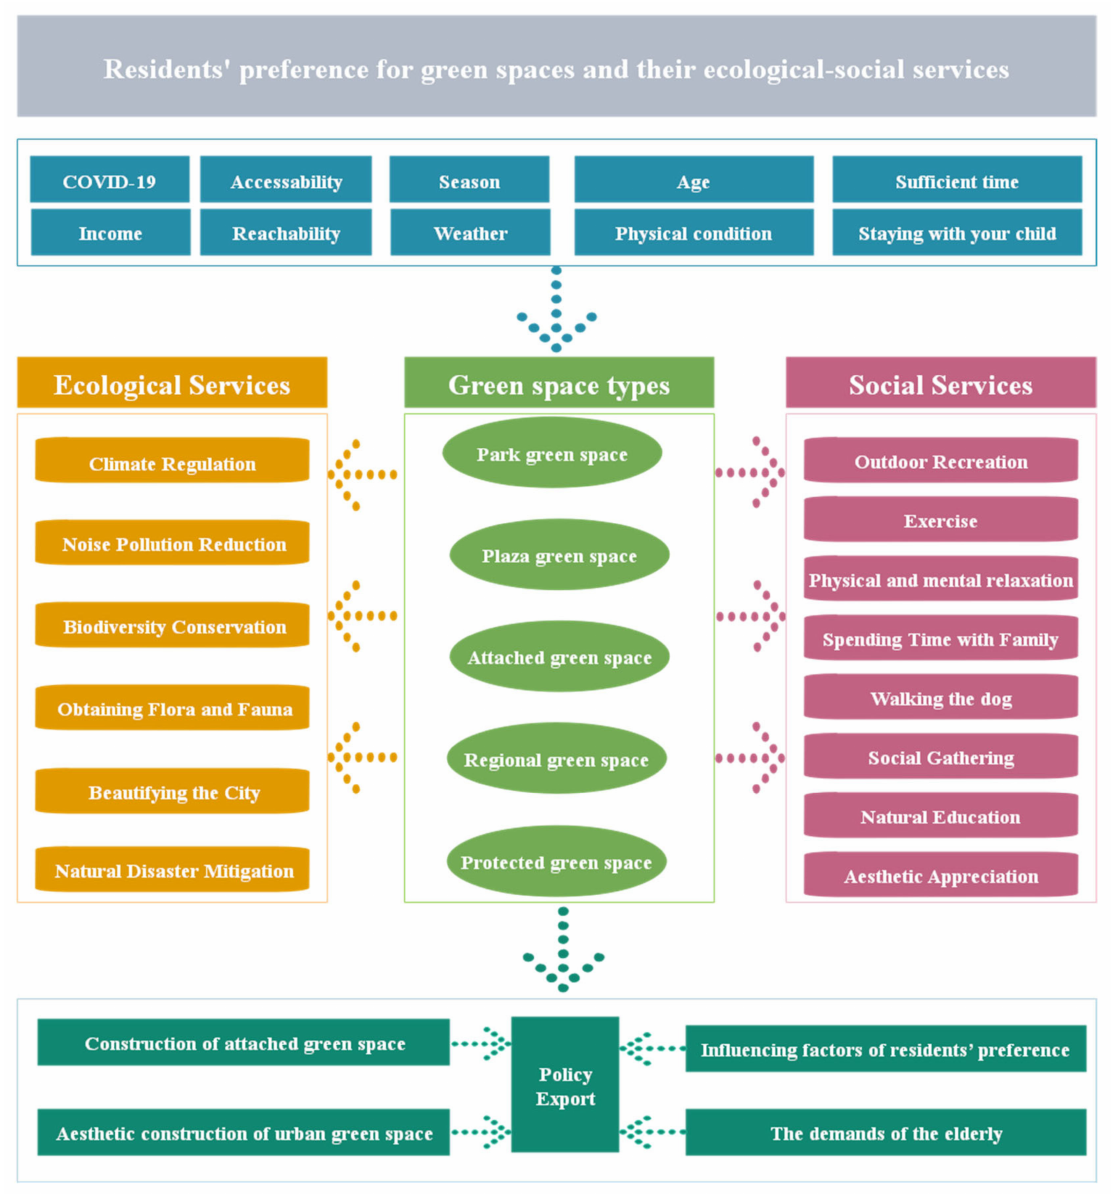
Figure 1. The overview of residents’ preference for UGS and their ecological and social